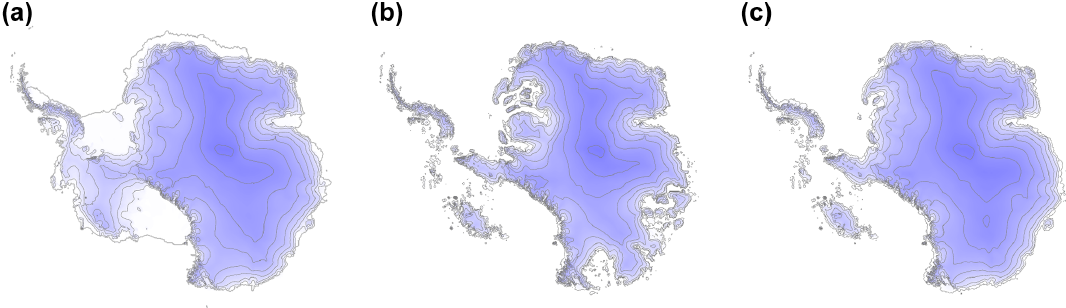
Figure 1. Antarctic ice sheet model simulations with mid-Pliocene boundary conditions from Pollard et al. (2015), showing ice surface elevation of grounded ice with contour lines at 500m intervals and ice shelf boundaries as a thick grey line. (a) Modern ice sheet configuration used as starting condition for model runs. (b) Mid-Pliocene warm period simulation with strong marine ice margin instability, showing extensive deglaciation of East Antarctic marginal basins. (c) Mid-Pliocene warm period simulation without marine ice margin instabilities, showing minimal ice loss in East